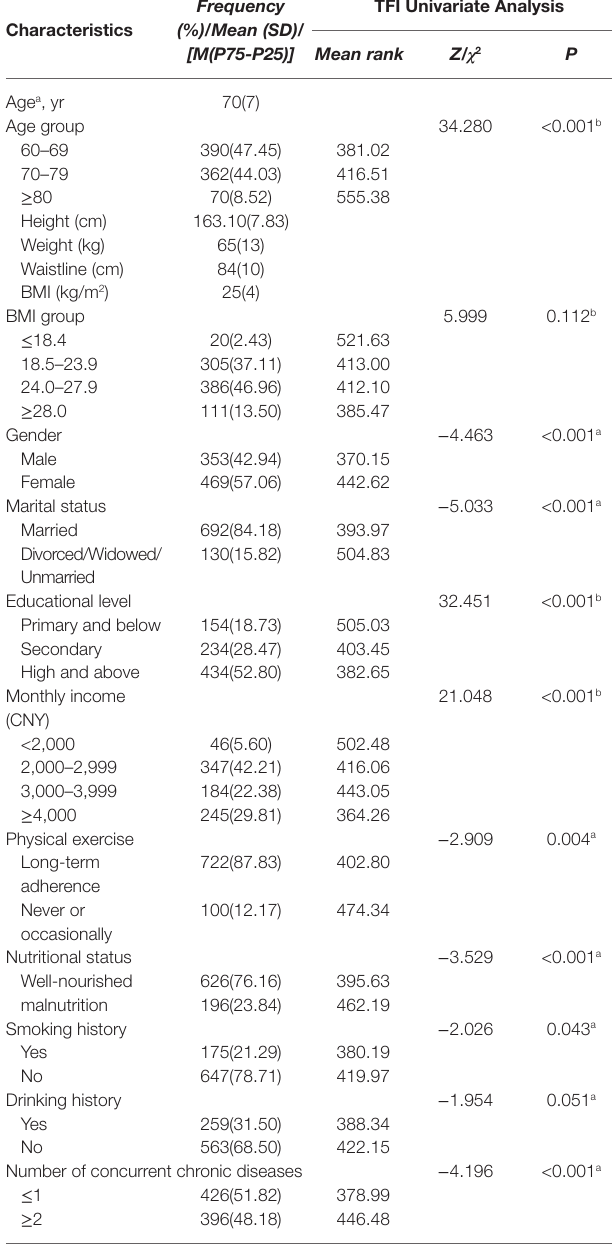
TABLE 1 | Frailty among older adults with different sample characteristics ( N =